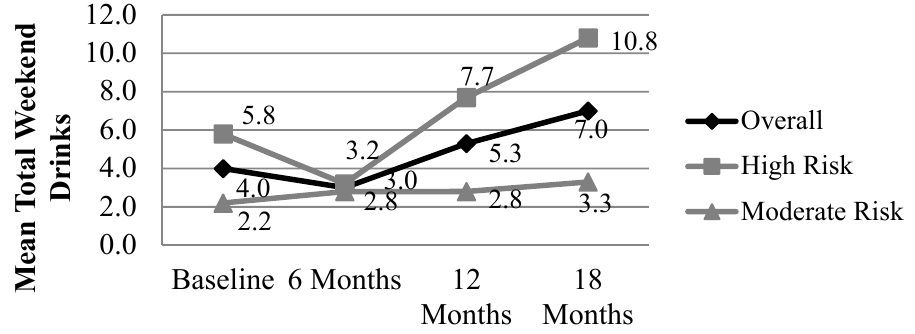
Figure 1. Total number of drinks consumed over the previous weekend at baseline and at 6, 12, and 18 month follow-up for women with data for all four time points ( n = 50). Risk group determined at baseline using a cutoff AUDIT score of 20 or higher to identify women with high-risk, dependent drinking; Repeated measures analysis, within- Ss effect, time: F = 5.037, p = 0.029; Repeated measures analysis, within- Ss effect, time x risk group: F = 2.573, p = 0.115; Repeated measures analysis, between- Ss effect, risk group: F = 5.758, p = 0.020.